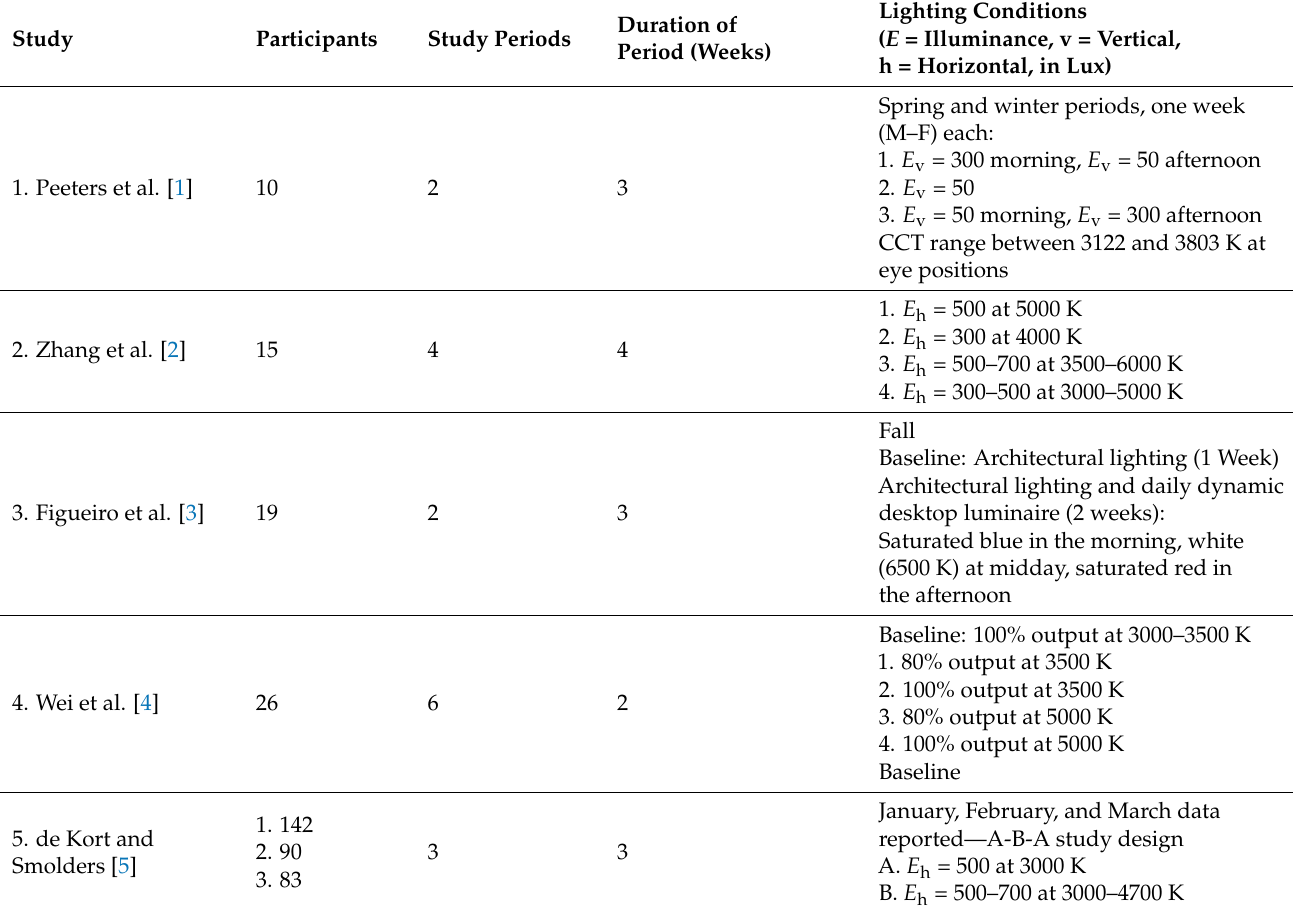
Table 1. Office field studies investigating occupant response to electric lighting intervention. The studies included in the review were all published in 2010 or later. All of the studies utilized or modified the architectural lighting in the study environment; one study also used a desktop luminaire.